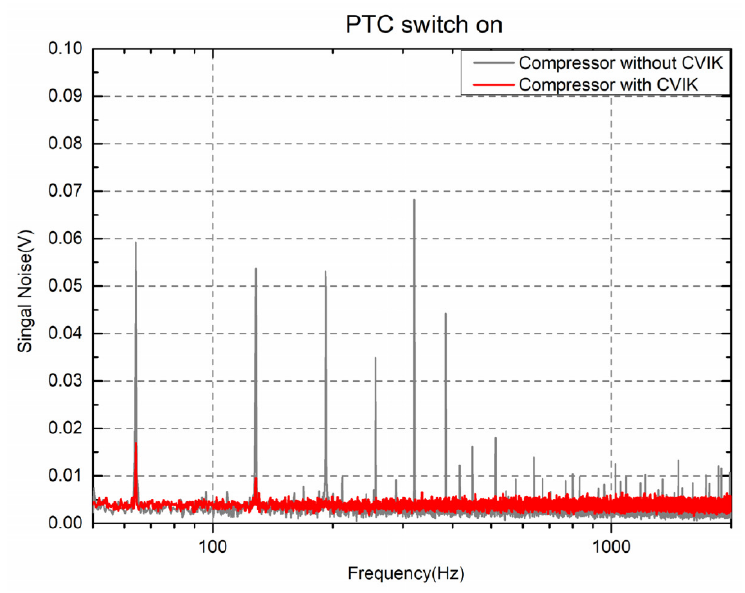
Figure 9. PTC switched on detector signal noise.